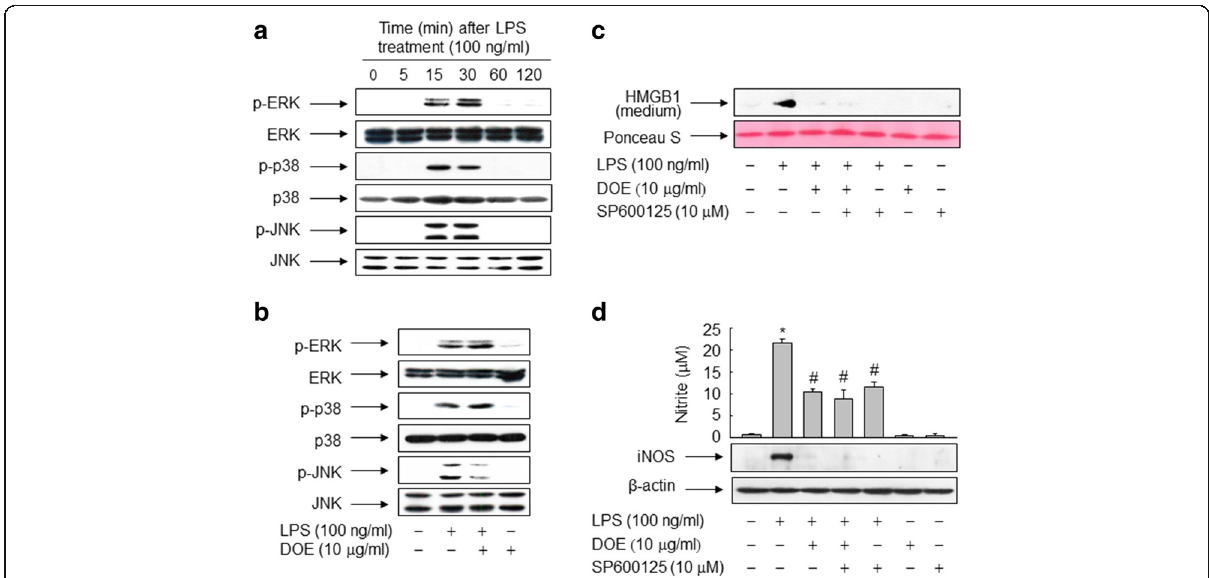
Fig. 8 DOE inhibits the LPS-triggered release of HMGB1 by suppressing phosphorylation of JNK via NO in RAW 264.7 cells. a Cells were treated with LPS for the indicated amounts of time. b Cells were stimulated with vehicle (DMSO) or LPS in the presence or absence of DOE for 30 min. Aliquots of whole-cell lysates were immunoblotted with activation-specific antibodies, and parallel immunoblots were analyzed for total kinase levels. c and d Cells were pretreated with SP600125 for 1 h and then exposed to vehicle (DMSO) or LPS with or without DOE. Following incubation for 24 h, aliquots of conditioned media or whole-cell lysates were subjected to immunoblot or nitrite analysis to detect HMGB1 ( c ) or iNOS and nitrite ( d ), respectively. The blots are representative of three independent experiments. The results are plotted as the means ± S.E. ( n = 5). * , p < 0.01 vs untreated group; # , p < 0.01 vs LPS-treated